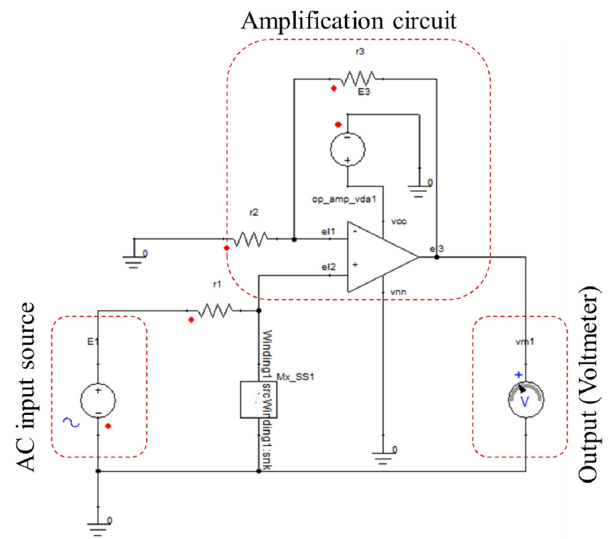
Figure 7. Circuit attached to the absolute